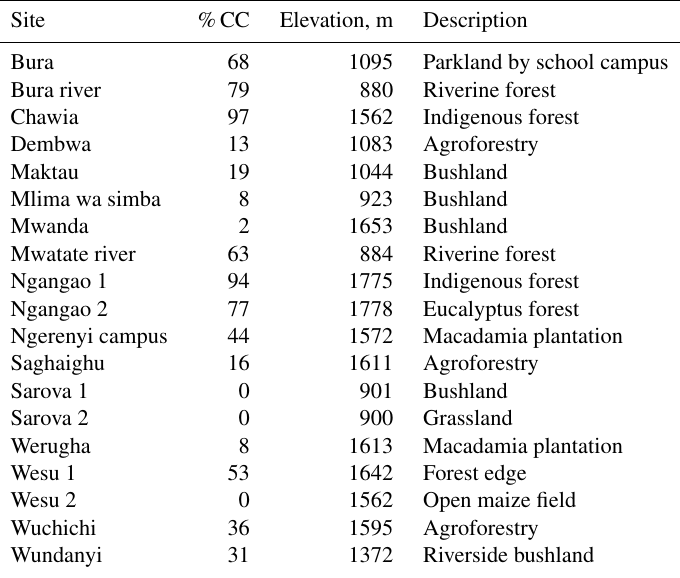
Table 1. Names, canopy cover (CC) percentages, elevations, and descriptions of field plot sites. Site %CC Elevation,